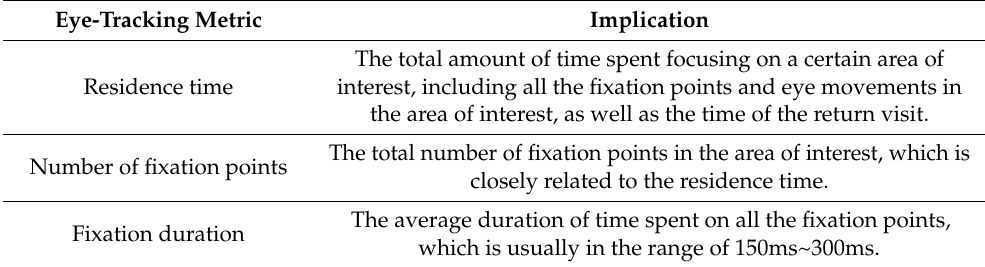
Table 1. Eye-tracking indicators in the eye-tracking experiment.